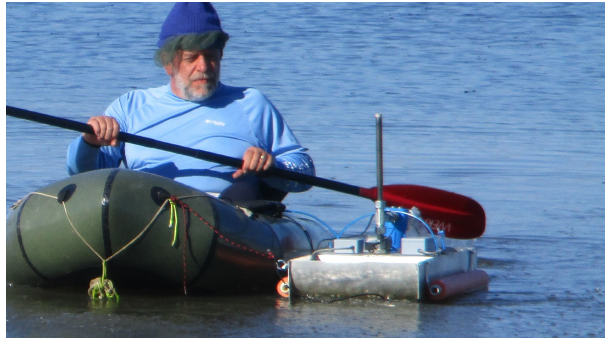
Figure 3. Prototype being operated on Esieh Lake (credit: Katey Walter Anthony).